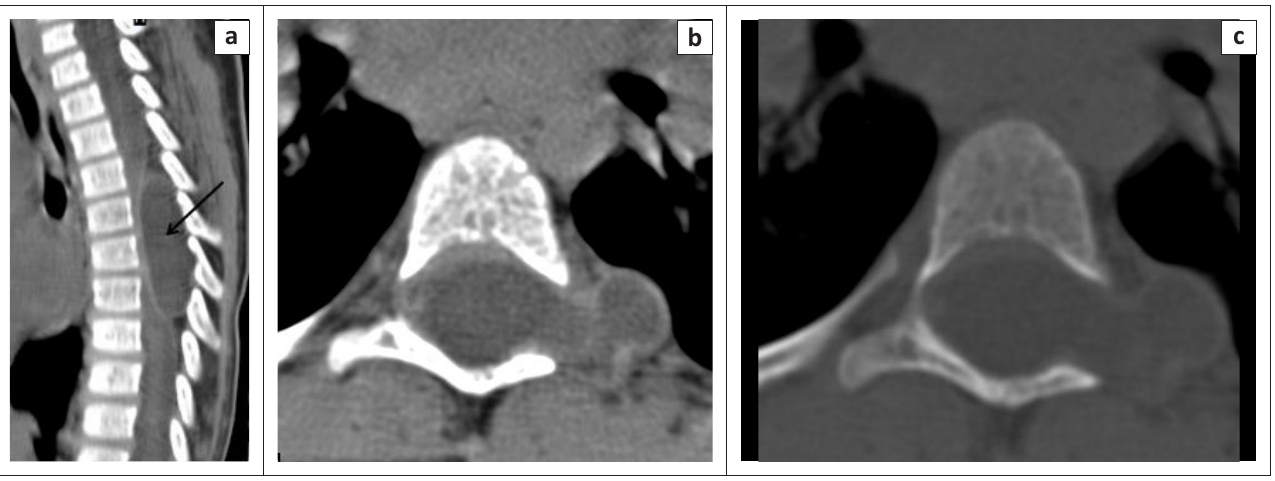
FIGURE 2: (a) CT scan of the thoracic spine sagittal view on bone window demonstrates a widened canal with oval-shaped extradural cystic mass; (b) Axial CT scan soft tissue window demonstrates cystic mass extending through left T7/6 intervertebral foramen; (c) same level as (b), bone window demonstrates enlarged exit foramen at that